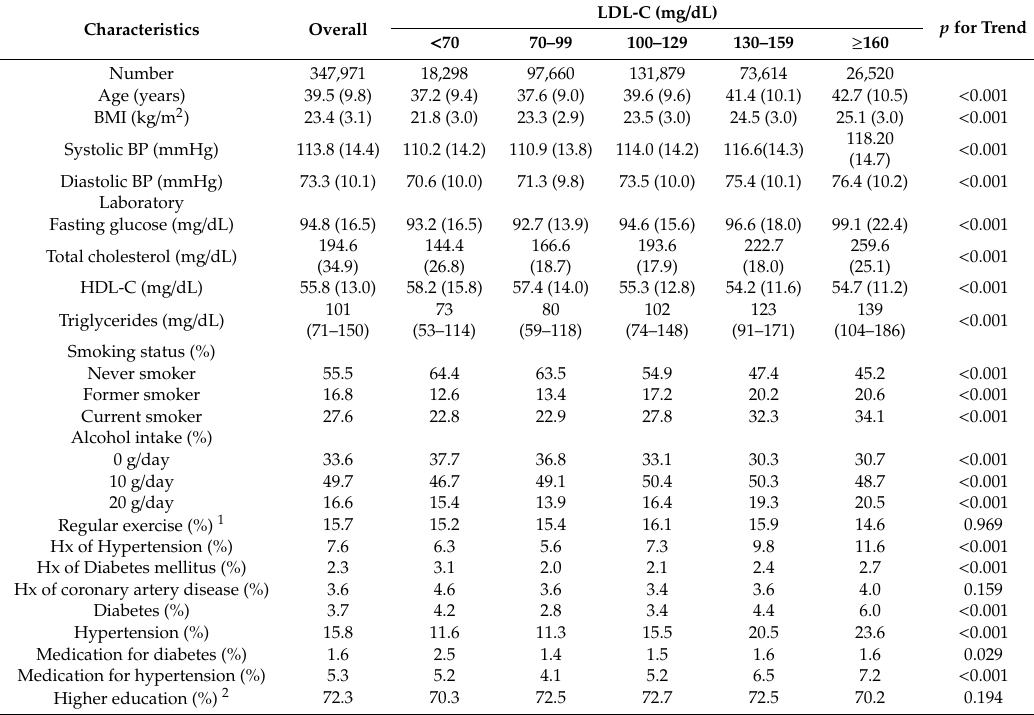
Table 1. Baseline characteristics of participants according to LDL-C concentrations in Kangbuk Samsung Health